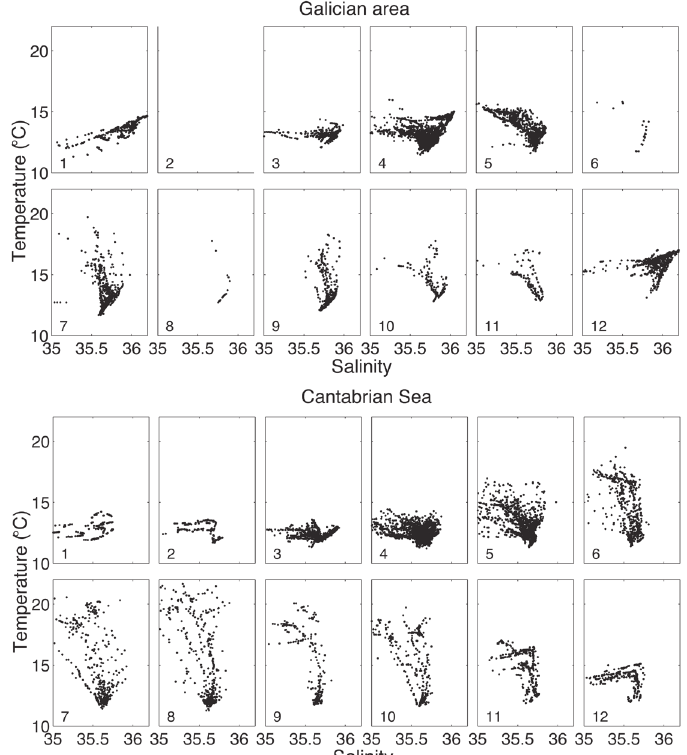
Fig . 6. – Monthly TS diagrams for the continental shelf area corresponding to the Galician Area (upper) and Cantabrian Sea